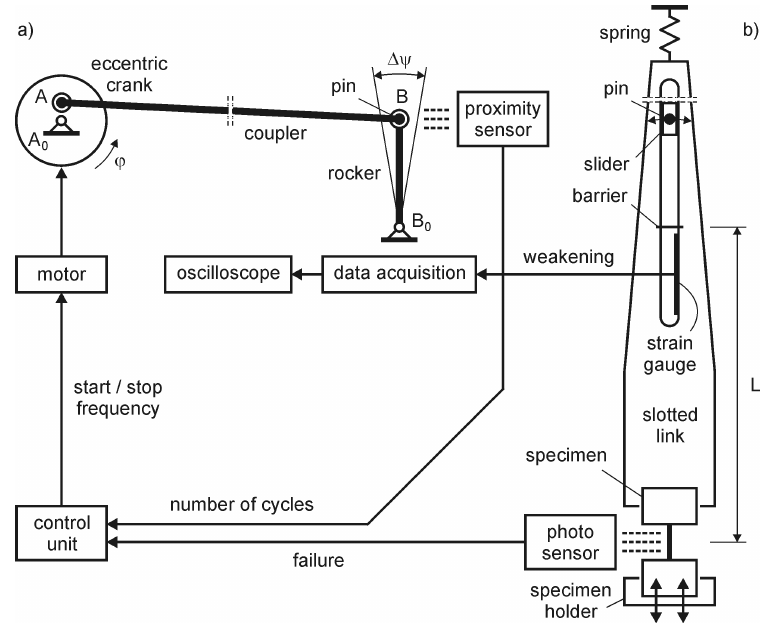
Figure 5. Schematic representation of the fatigue test bench: (a) back side, (b) front side.